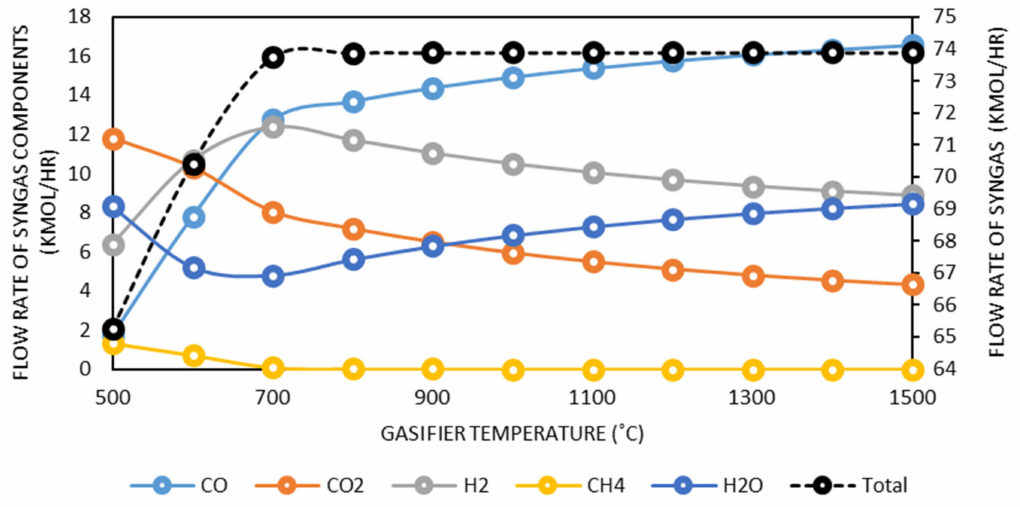
Figure 3. E ff ect of gasification temperature on molar flow rates of syngas